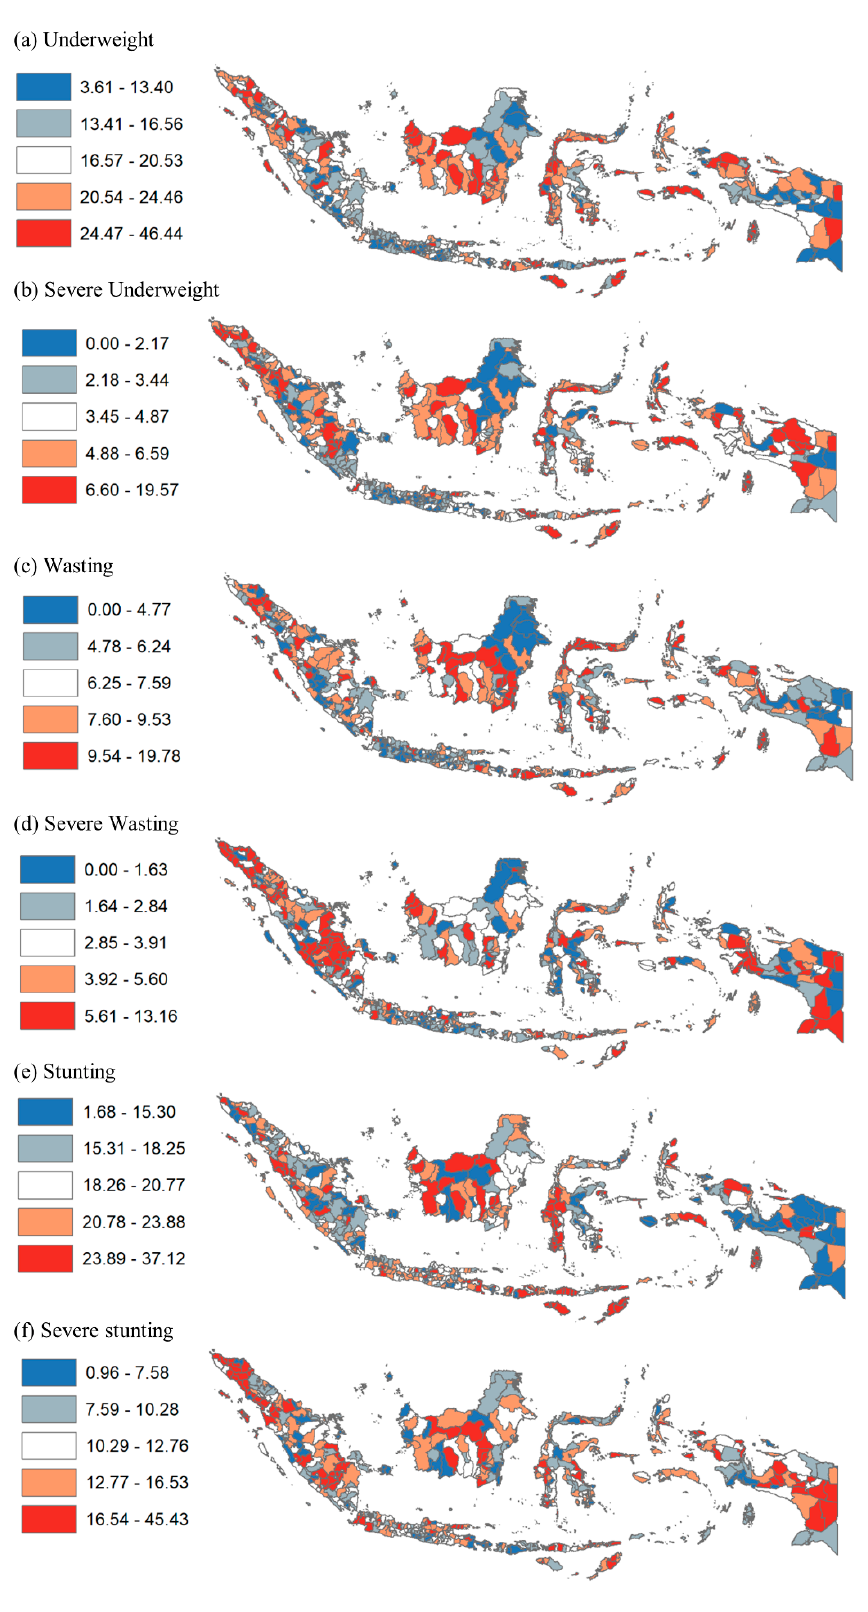
Figure 3. Disparity of Child Undernutrition by District in Indonesia, 2018. Note: Values show prevalence of child undernutrition.